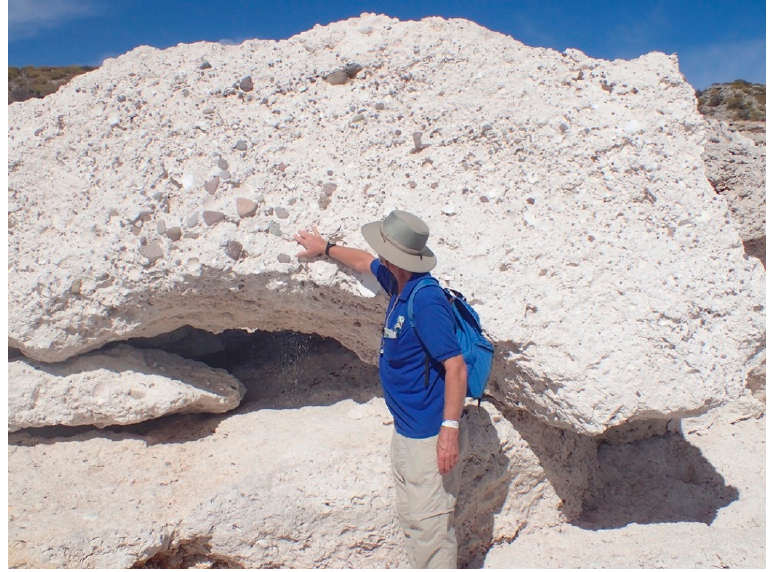
Figure 3. Large block of Pliocene limestone tilted on edge near the rim of the 12-m terrace at Arroyo Blanco, showing a basal layer with andesite cobbles that can be matched to an intact surface, below.